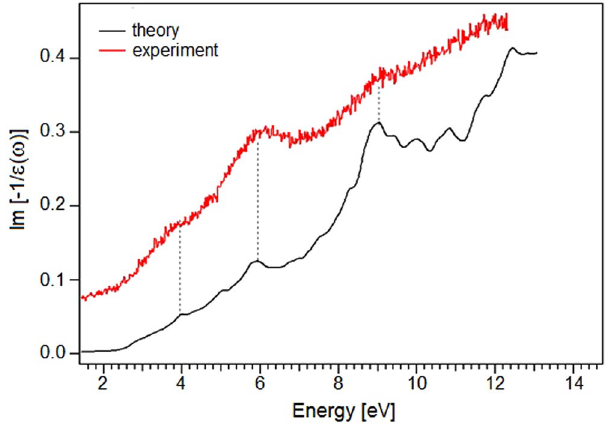
Figure 6. Comparison between the EELS spectrum and the calculated L || ( ω ) function.